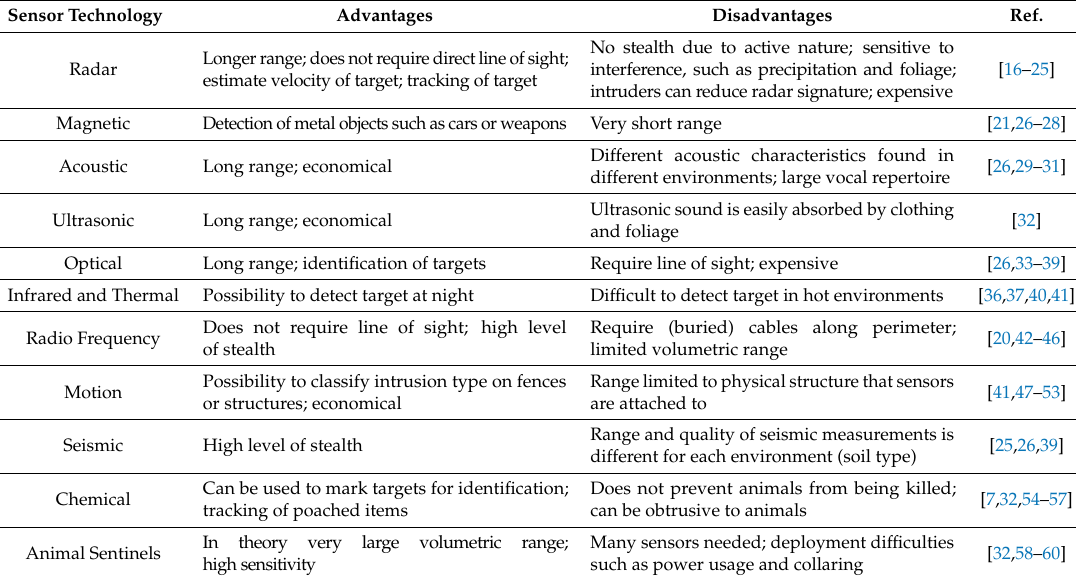
Table 2. Comparison between sensor